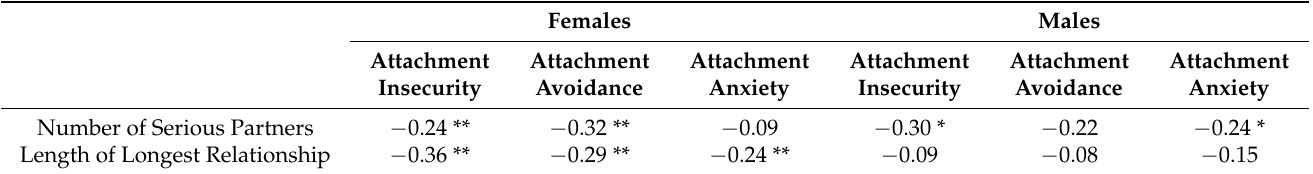
Table 3. Correlations Between Attachment and Relationship Measures by Gender.